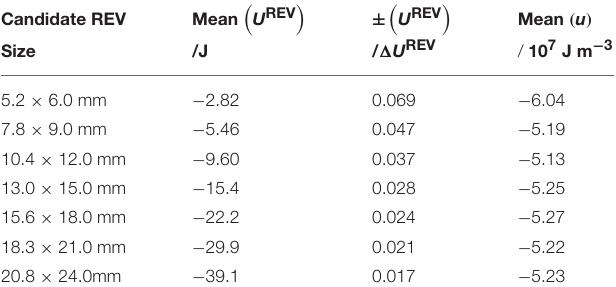
TABLE 2 | Mean values of U REV and u for candidate REVs of different sizes, along with the standard deviation of U REV divided by 1 U REV . The latter quantity represents a measure of the relative size of the fluctuations in U REV